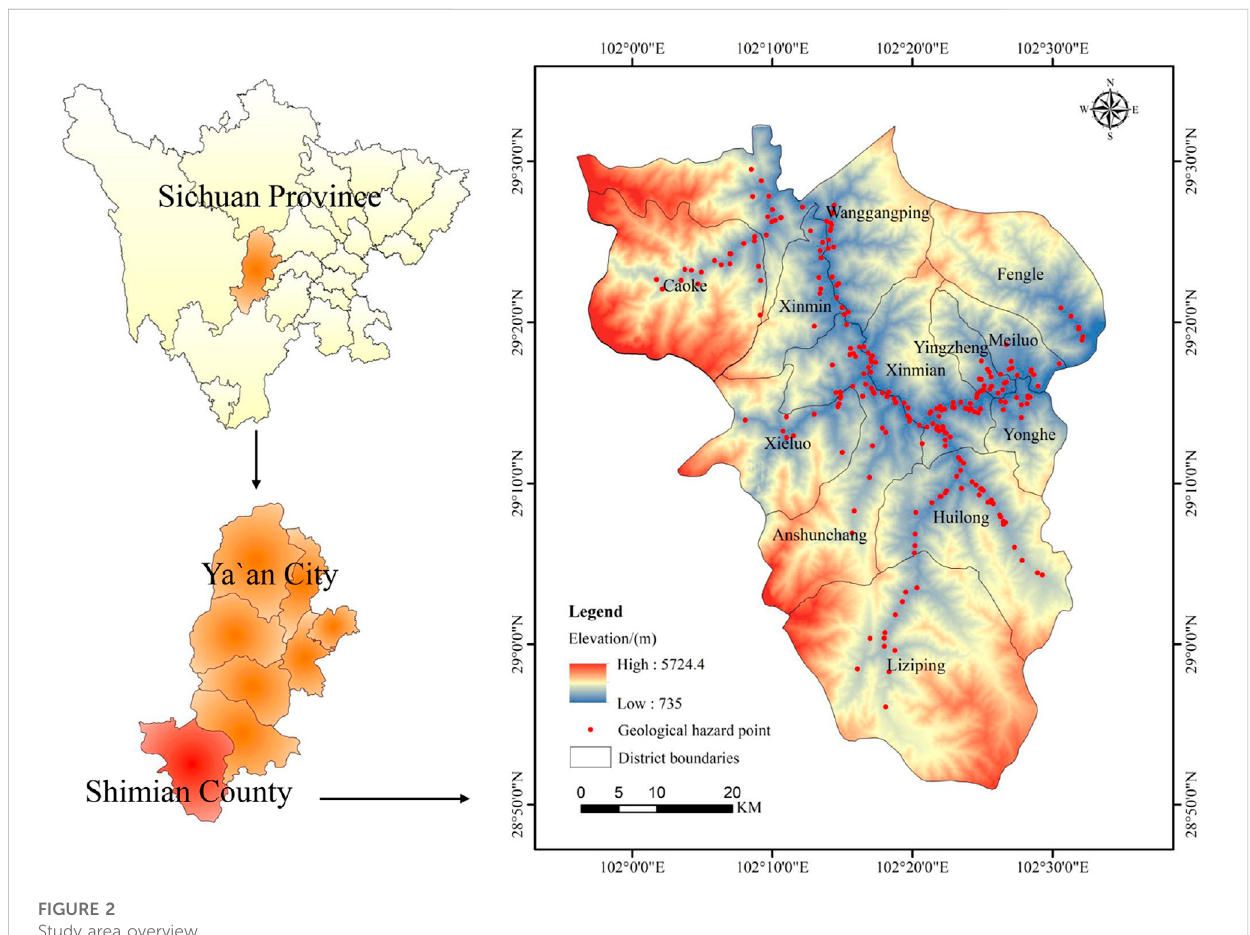
FIGURE 2 Study area